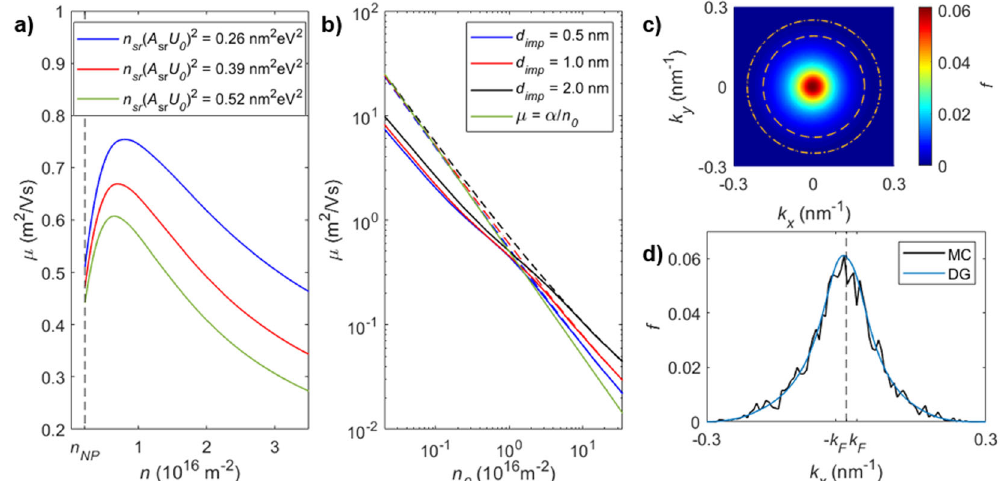
Fig. 2 Boltzmann equation results for the mobility characteristics of doped graphene. a Mobility, μ , calculated using our Discontinuous Galerkin (DG) model as a function of gate-induced carrier density, n , beyond the minimum carrier density, n NP (vertical dashed line), for varying short-range scattering strengths. The impurity density is n 0 = 0.6 × 10 16 m − 2 . b Mobility, μ , calculated as a function of impurity density, n 0 , for several stand-off distances, d imp . Dashed curves are calculated using the linearised Boltzmann (LB) approximation, using Eq. (8), the solid green curve shows the constant-capacitance approximation from ref. 21 , where α = 20 e / h . c Final distribution of electron momentum calculated for a small impurity density, n 0 = 0.025× 10 16 m − 2 , at a distance d imp = 1 nm and carrier density, n = n NP = 0.016 × 10 16 m − 2 found using the DG simulation. Orange dashed circle represents the K -phonon level and the orange dashed-dotted circle represents the Γ -phonon level. d Cross-section of c for k y = 0 (solid blue line) compared to the result of Monte Carlo simulations. The Fermi wavenumber, k F , marks the bounding limit of the initial low temperature